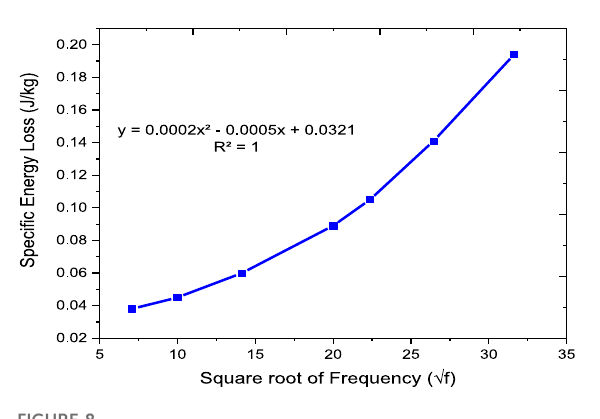
FIGURE 8 Total power loss per cycle of a magnetic sample made of non- oriented steelata1.5 T fl uxdensity against thesquare rootof